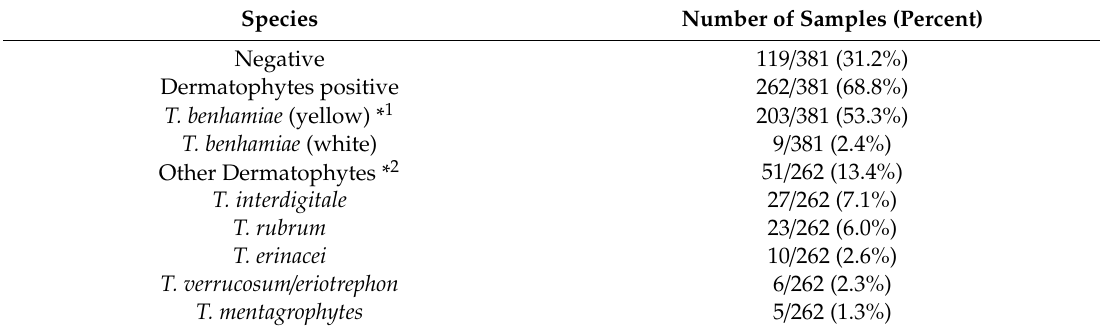
Table 1. Detection of dermatophytes on breeding guinea pigs (* 1 —both types were present in one animal / * 2 —partly mixed infections).